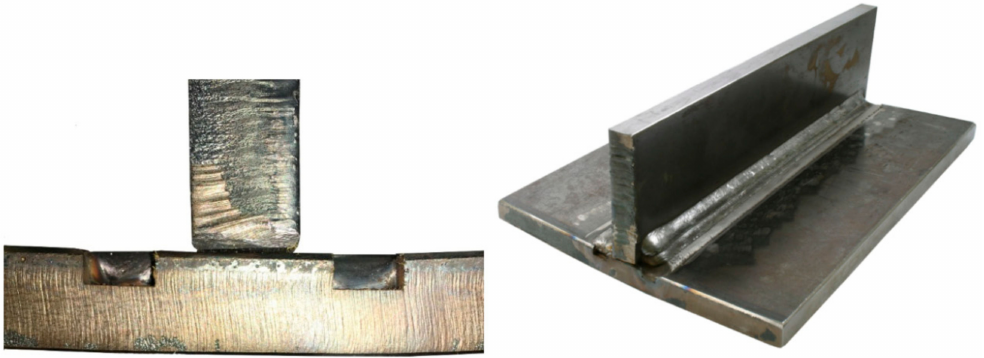
Figure 7. Geometry to illustrate the multi-material design under cyclic